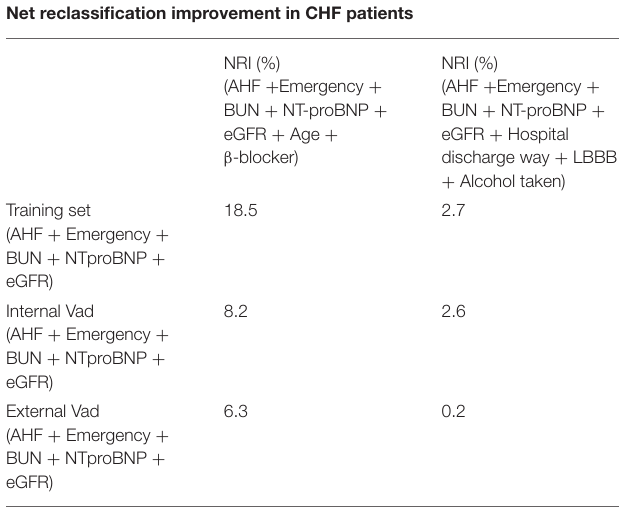
TABLE 3 | Net reclassification improvement in CHF patients who had unplanned readmission in the three patient sets. Net reclassification improvement in CHF patients